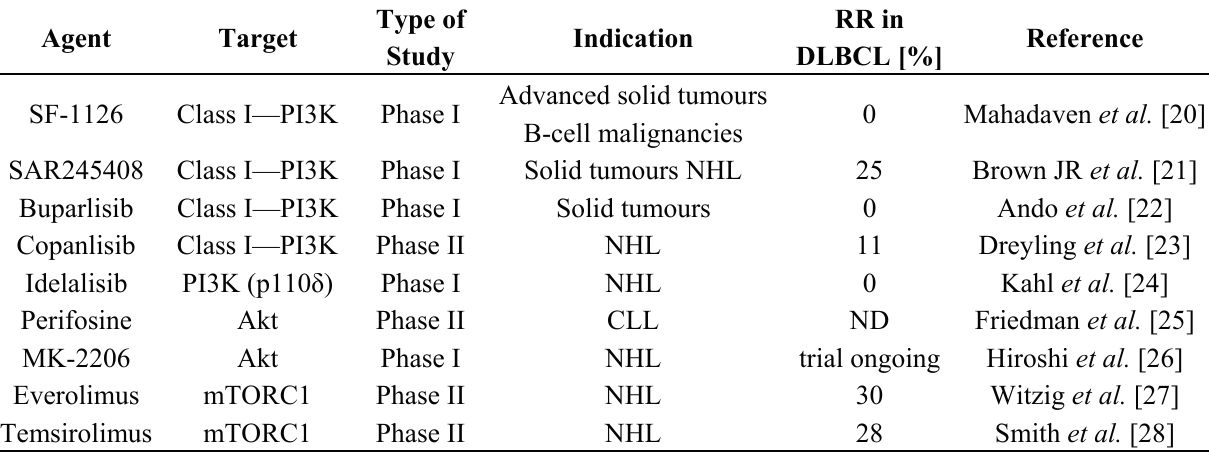
Table 1. Selected clinical studies of targeted therapy in patients with diffuse large B-cell